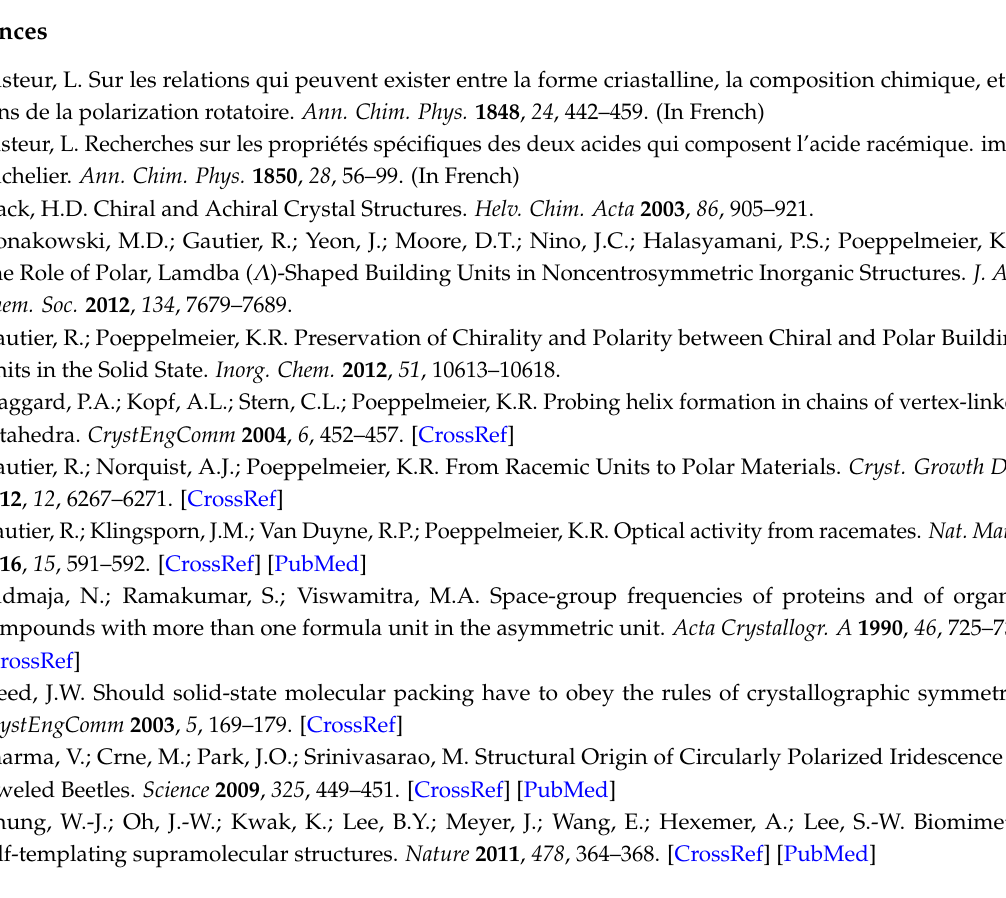
and Table S1: Crystal data and summary of data collections, structure solutions and refinements for compounds [Zn(2,2’-bpy) 3 ] (NbF 6 ) 2 (space-group P3 1 ) (I) and [Zn(2,2’-bpy) 3 ](TaF 6 ) 2 (space-group P3 1 ) (II); Figure S1: View along c and b of the structure with the relative orientation of the distortion represented by the shortest Nb-F bond. Along a and b axes, the individual dipole moments are canceled by the 3 n screw axis along c . The alignment of the individual polarizations is collinear to the polar axis of the